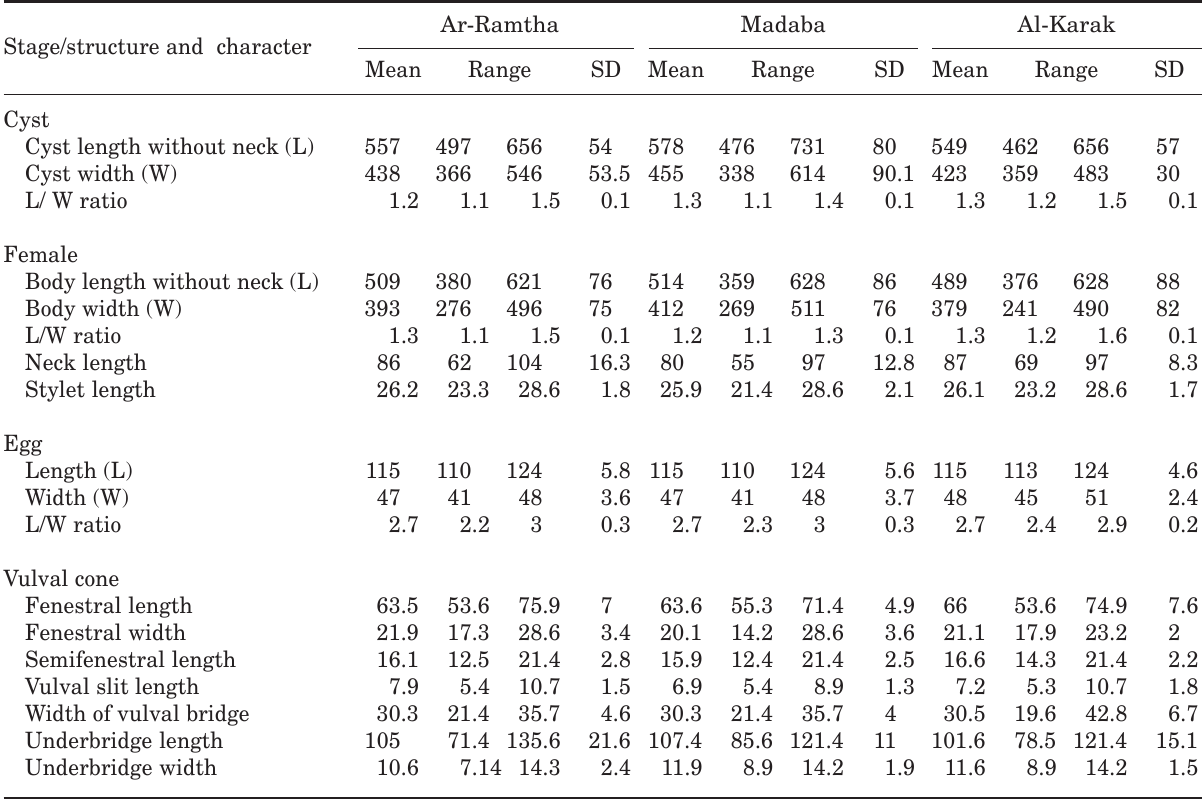
Table 2. Morphometric data (µm or ratio) of cysts, females, eggs and vulval cones (n=10) of three Heterodera latipons